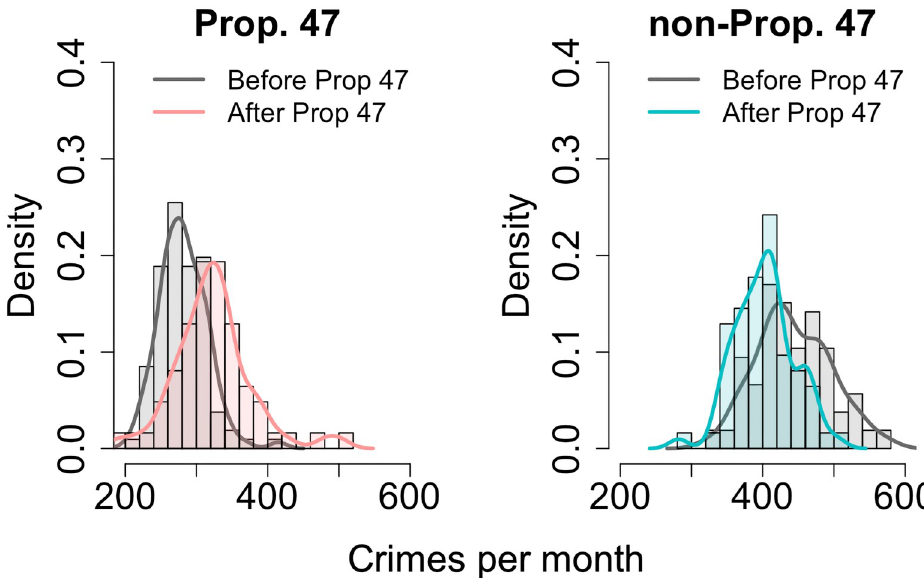
Fig 4. Reported crimes per month in Santa Monica, CA, before and after implementation of Prop. 47 in November, 2014. For Prop. 47 crimes (left panel) the monthly average before implementation of the new law was 281.4 crimes, whereas after November, 2014 the average was 322.9 crimes per month. A Welch’s t-test shows that this 14.7% increase is statistically significant ( p < 0.05). The same computations applied to non-Prop. 47 crimes (right panel) show that, to the contrary, non-reclassified crimes decrease by 9.2%, from 443.2 to 402.4 per month, after passage of the initiative. A Welch’s t-test shows that this 9.2% decrease is statistically significant ( p < 0.05).